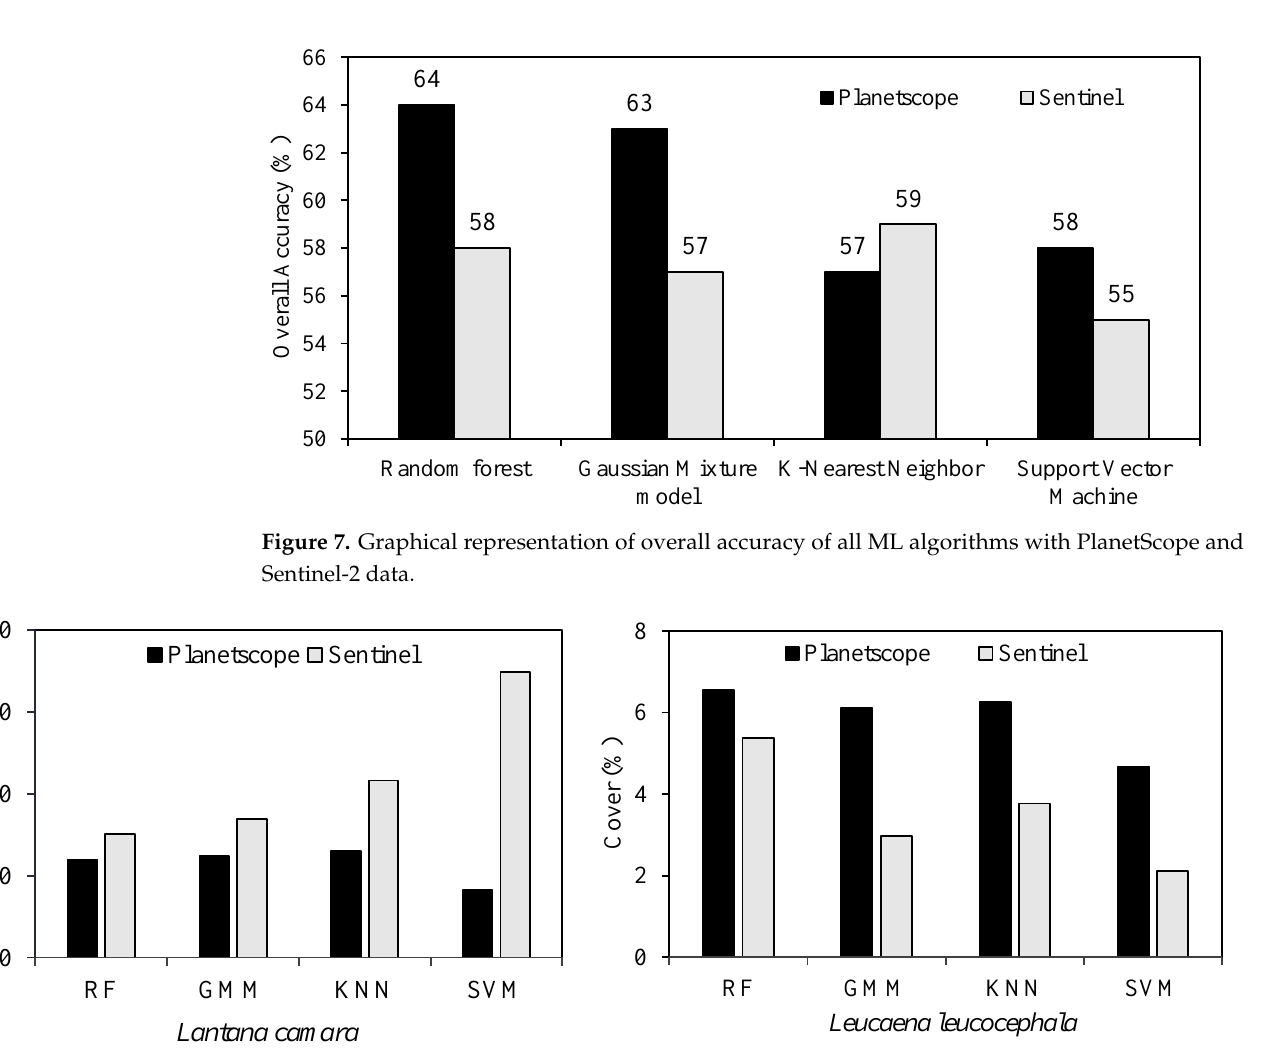
identify the same general areas on the maps as invasive species, although there were some